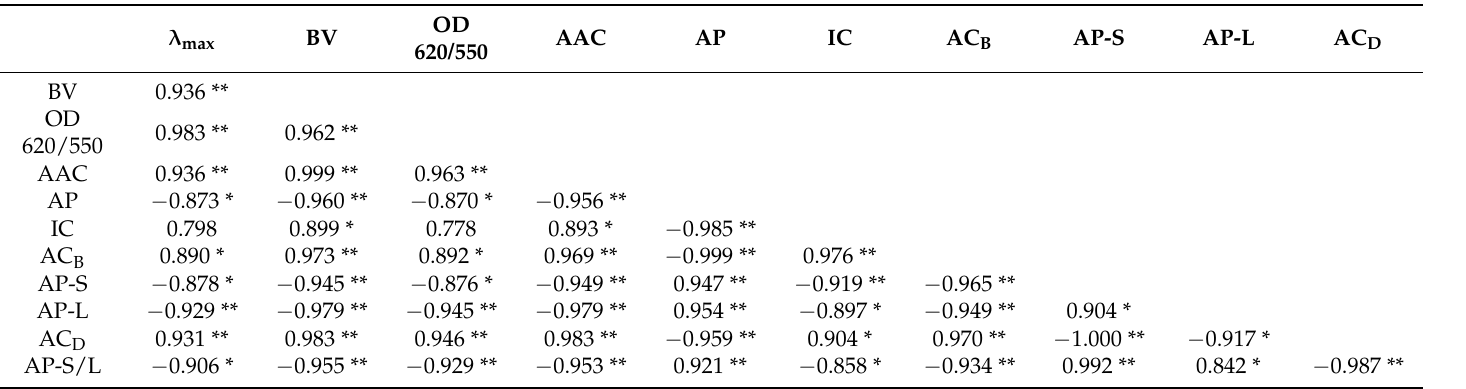
Table 3. Pearson correlation coefficients between molecular structural parameters of starches a